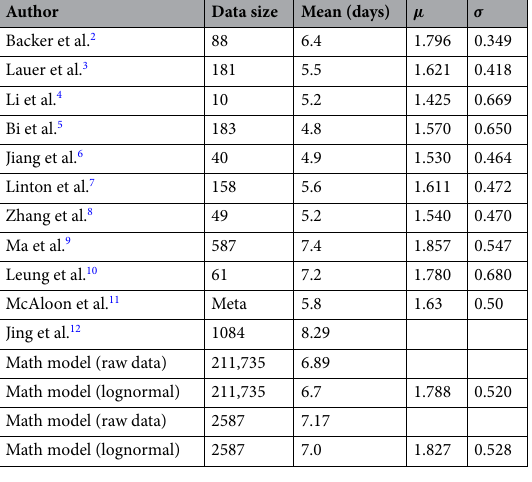
Table 1. A list of several studies along with sample size, mean and lognormal parameters µ , σ